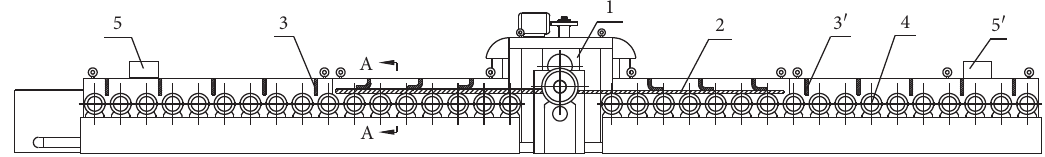
Figure 7: Structure diagram of the conveying roller with cathodic protection of a hanging bare wire. 1, rolling mill; 2, magnesium plate; 3, hanging bare wire; 4, motor; 5, adjustable power box.